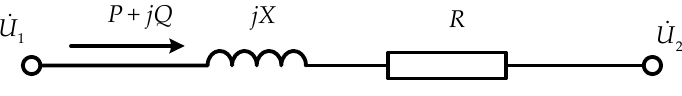
Figure 3. Simplified model of transmission line.